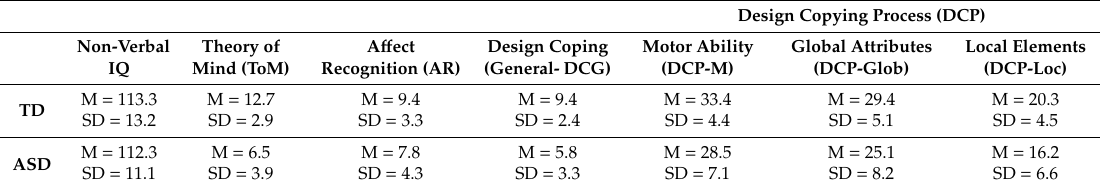
Table 1. Main scores for each test and group. Each cell contains the average score (M) and its standard deviation